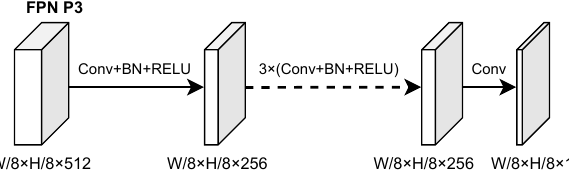
Figure 8. Illustration of the architecture of BGS head. W and H represent the origin width and the length of the input image, respectively. The feature map size is displayed as (width × depth × channel). Arrows indicate stacked 3 × 3 conv layer, while the final map represents the predicted boundary map whose size is W/8 ×